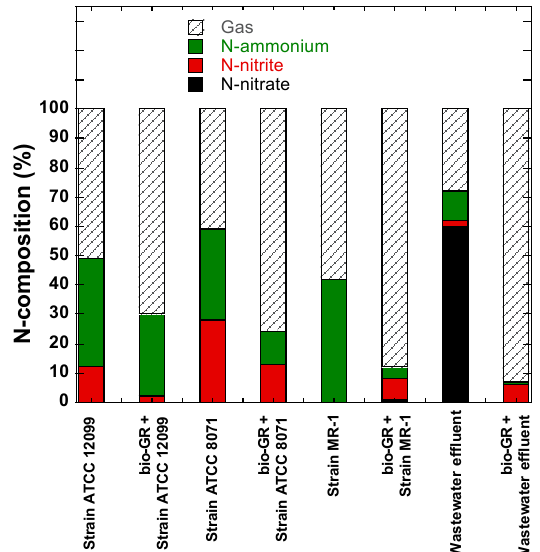
Figure 5. Initial rates of nitrate reduction by S. putrefaciens ATCC 12099 ( a,d ), S. putrefaciens ATCC 8071 ( b,e ), and S. oneidensis MR-1 ( c,f ) in the absence and presence of biogenic iron(II-III) hydroxycarbonate green rust. All experiments were carried out in triplicate, except for those performed with strains ATCC 12099 and ATCC 8071 in the absence of bio-GR(CO 3 ), which were in duplicate. Error bars correspond to standard deviations of replicate experiments. Initial rates of nitrate reduction were calculated using a linear regression fitting (dashed lines) procedure in the time interval between time zero and 90 min for ATCC 12099 and ATCC 8071, between time zero and 30 min for MR-1, and between time zero and 60 min for all experiments carried out in the presence of bio-GR(CO 3 ).